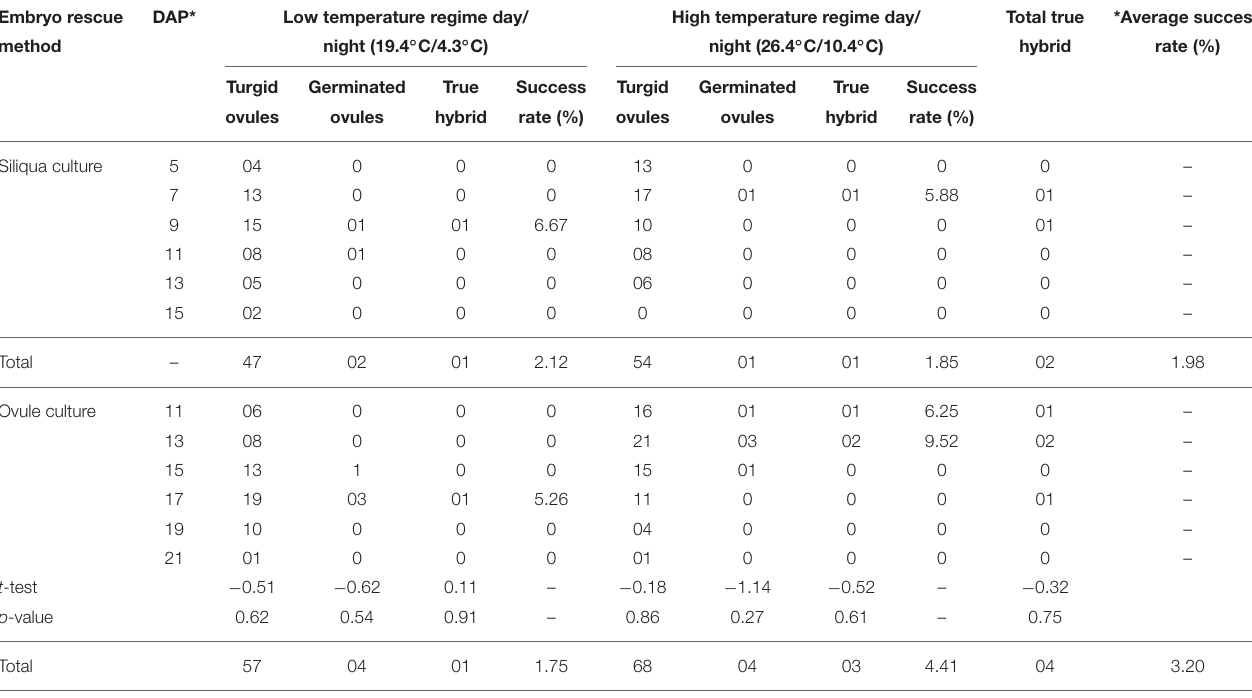
TABLE 1 | Effect of days after pollination on siliqua and ovule culture of inter-specific hybrid of Brassica oleracea botrytis group and Brassica carinata and under different temperature regime. Embryo rescue